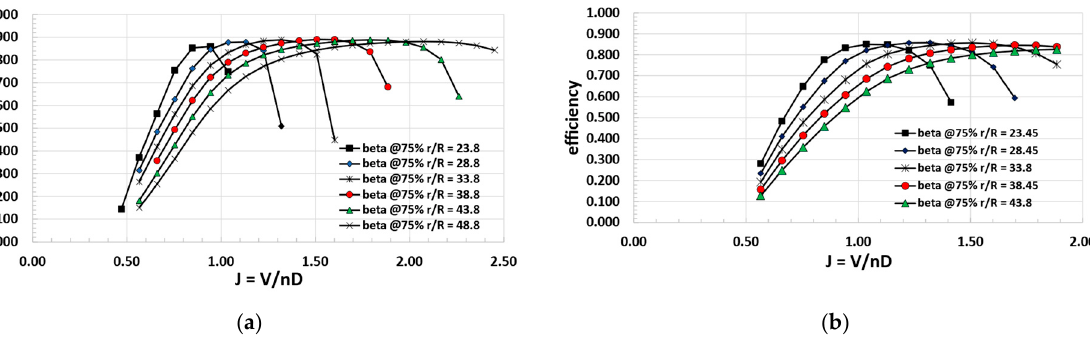
Figure 11. Propellers efficiency map (different blade pitch angles). ( a ) Tip propeller. ( b ) DEP propeller.